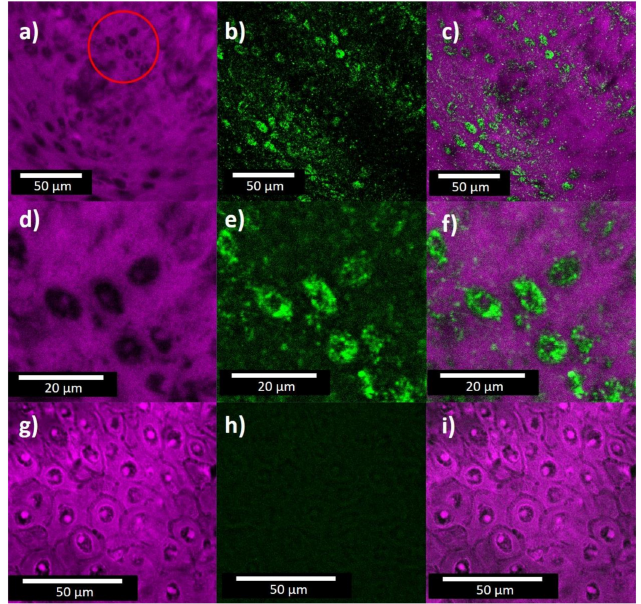
Figure 3. Micrographs of carcinogenic cervical tissue, ( a ) confocal image of tissue with Au NPs, excited at 543 nm; ( b ) two-photon imaging of cervical tissue with Au NPs, excited at 900 nm; ( c ) superposition of images from panels ( a and b ); ( d – f ) zoom in of the red circled region in panel ( a